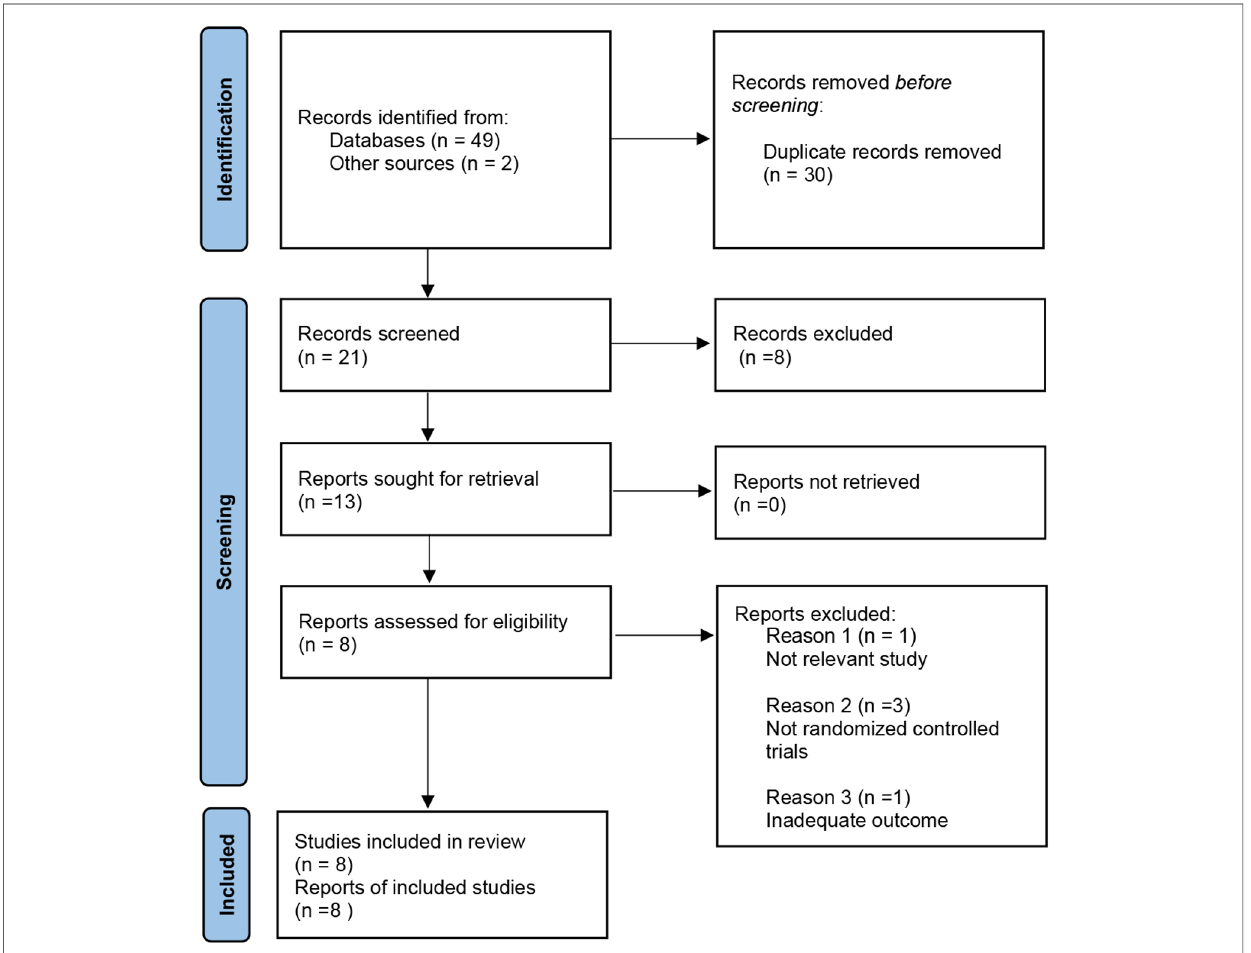
FIGURE 1 Flow diagram of the study selection process for the